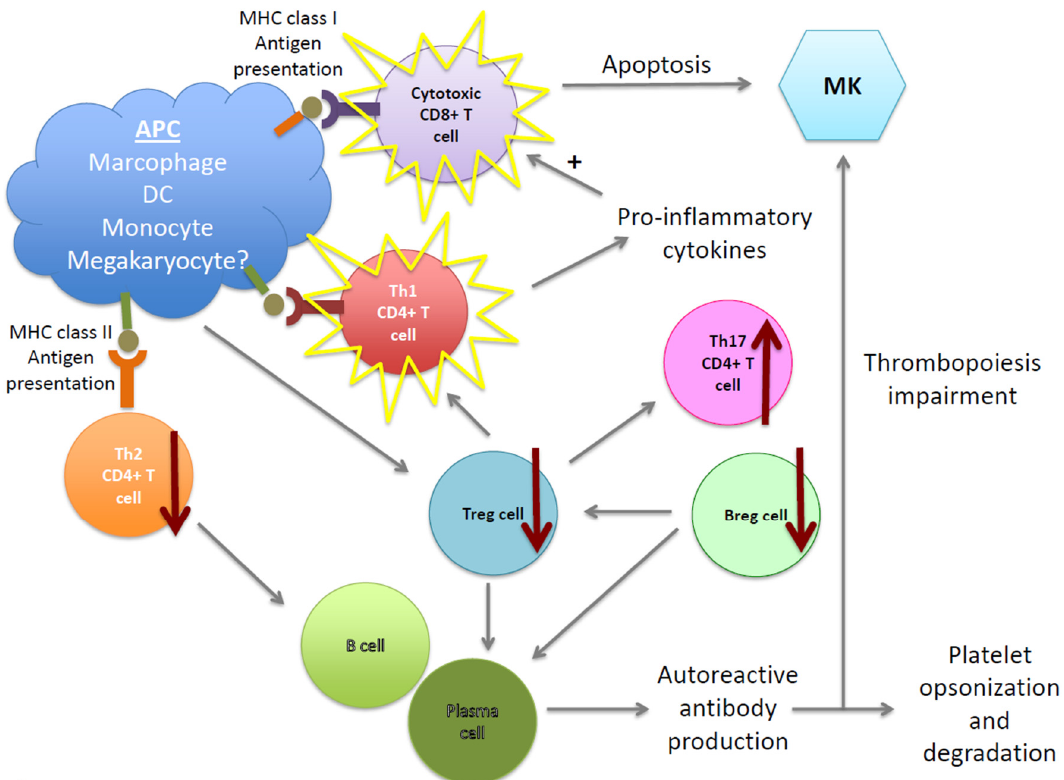
Figure 1. Cellular pathogenic mechanisms in immune thrombocytopenia (ITP). Multiple cells are involved in the pathogenesis of ITP. B cells and plasma cells are abnormally regulated and produce autoantibodies, which bind platelets and megakaryocytes (MKs), inducing their impairment and/or degradation in the spleen and liver. The cellular immune response is also affected, leading to a decrease of Tregs and Bregs, which contributes to autoreactive plasma cell survival (supporting autoantibody production) and unbalanced Th CD4 + T cell subsets. Moreover, cytotoxic CD8 + T cells are also activated, inducing platelet and MK apoptosis as well as the dysregulation of BM niche homeostasis. Therefore, ITP pathogenesis does not only results in platelet destruction, but also in a megakayopoiesis and thrombopoiesis defect.